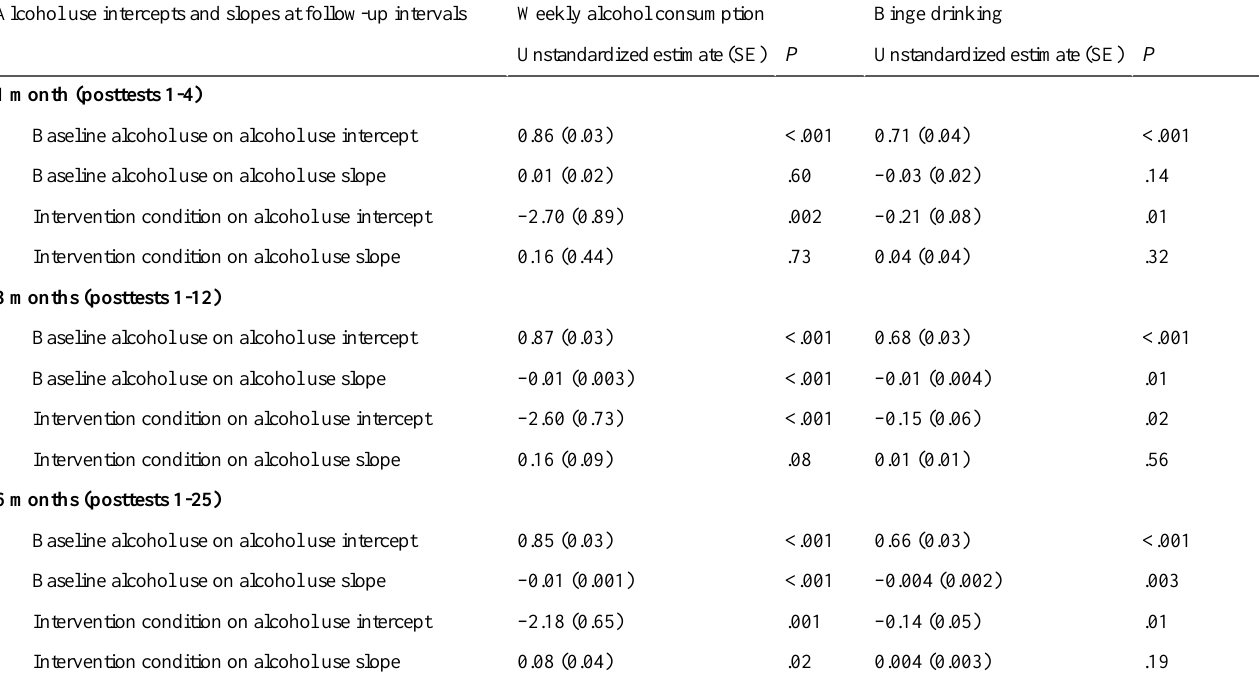
Table 2. Latent growth curve models presenting alcohol use intercepts and alcohol use slopes of intervention effects on alcohol use at 1-, 3-, and 6-month follow-up intervals (N=907).